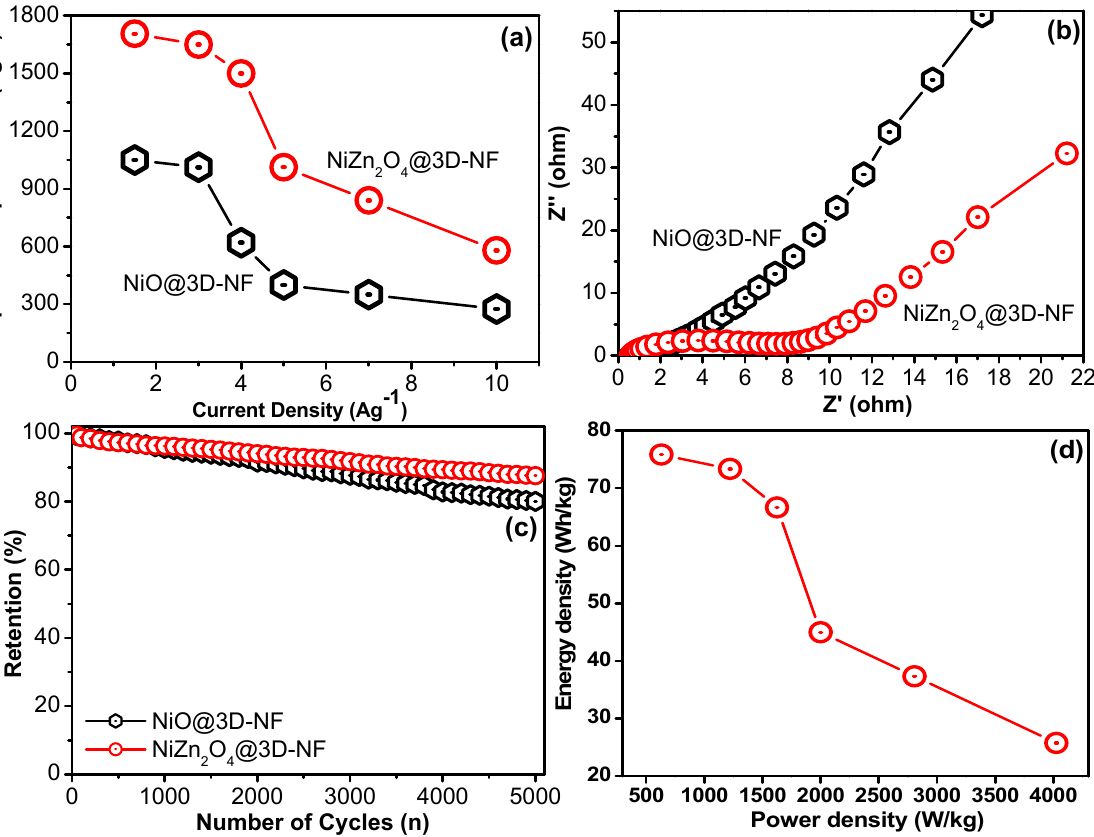
Figure 5. ( a ) Calculated specific capacitance of NiO@3D ‐ NF and NiZn 2 O 4 @3D ‐ NF; ( b ) Nyquist plot of NiO@3D ‐ NF and NiZn 2 O 4 @3D ‐ NF; ( c ) cycling stability graph of NiO@3D ‐ NF and NiZn 2 O 4 @3D ‐ NF; ( d ) Ragone plot of NiZn 2 O 4 @3D ‐ NF.